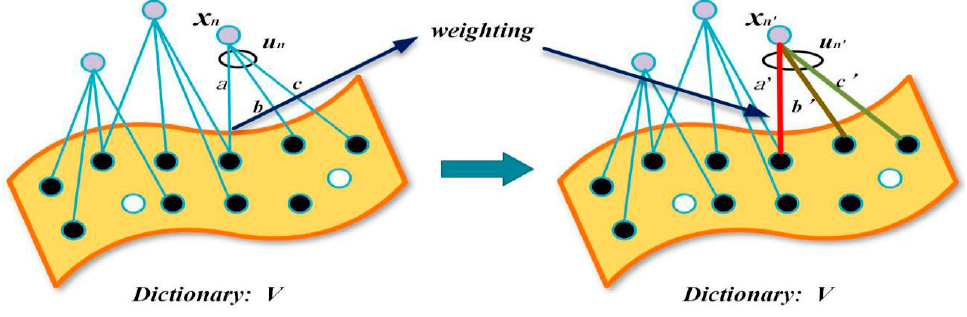
Figure 6. Dictionary training.